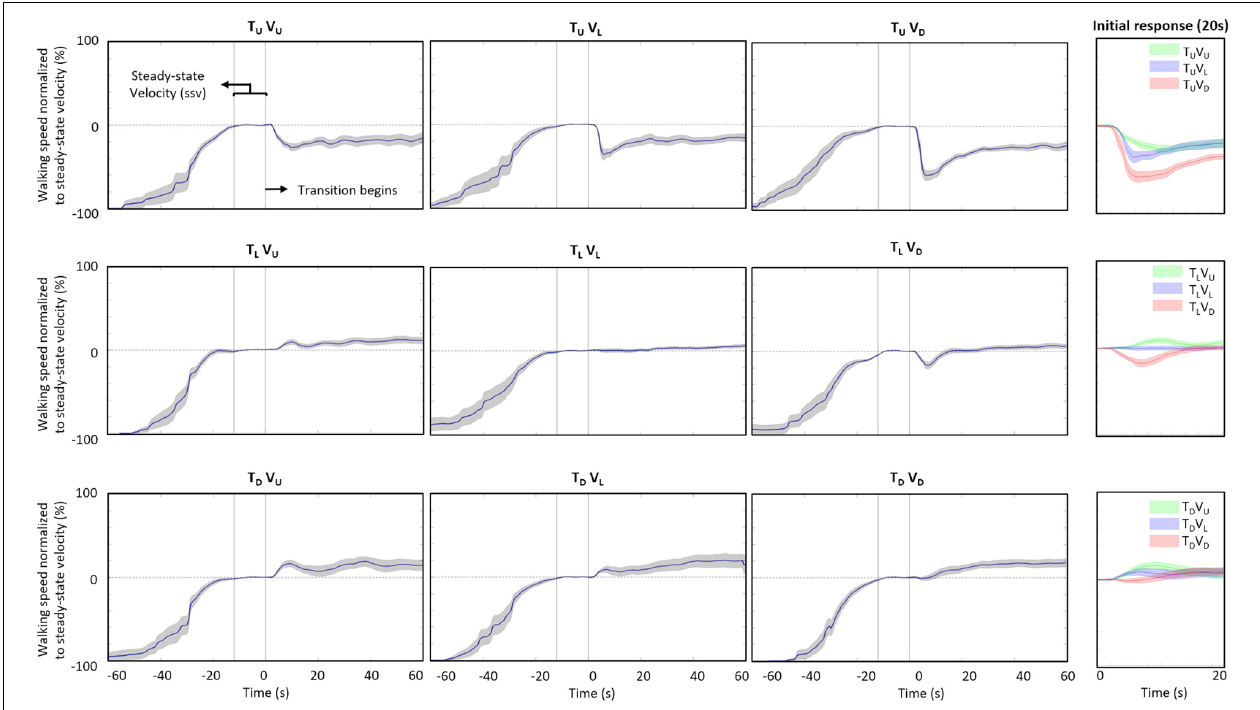
FIGURE 2 | Adaptation of walking speed. Average self-paced walking speed (15 participants) relative to steady-state velocity for each condition (see values in Supplementary Table S1 ). Data is shown in a 3 × 3 matrix, with rows representing inclination of the treadmill (T) and columns inclination of the visual scene (V) upon transition (of the treadmill and/or visual scene) from its original level (L) inclination to a 10 ◦ uphill (U) or downhill (D) inclination. No transition occurred for the T L V L condition. Time zero marks the end of the steady-state velocity period, after which the transition occurred for 5 s. Gray shading represents the standard error. To facilitate comparison, the rightmost column shows magnified data for each treadmill inclination for the 20 s post-transition, with data for all visual scene inclinations plotted on the same graph (U: green; L: blue; D: red). Irrespective of treadmill inclination upon transition, there is a tendency for downward visual transition to decrease walking speed and, to a lesser degree, for upward visual transition to increase walking